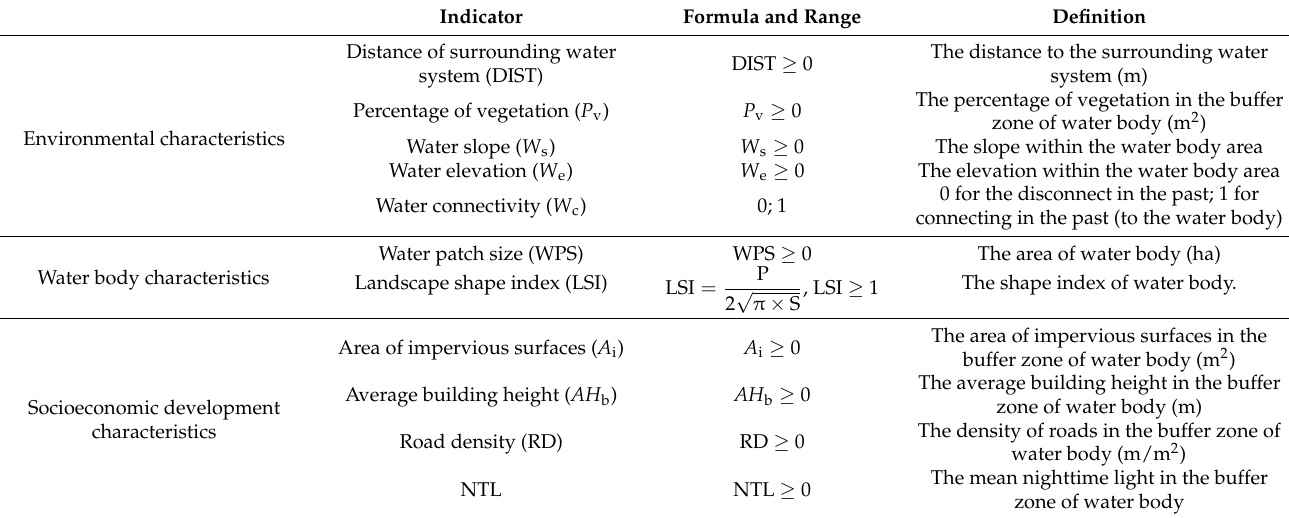
Table 1. The selected influencing factors in this research.